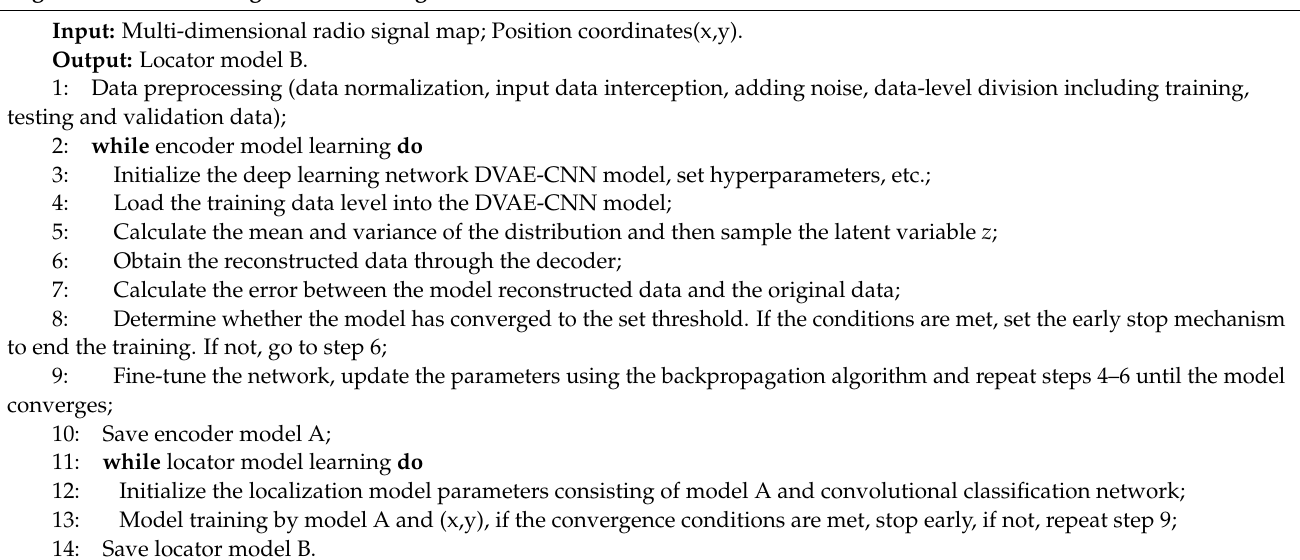
Figure 9. Locator model training process. The output of the encoder is converted into the input format of the CNN model through the Reshape method. At this time, the input feature is the high-level latent feature z related to the position, and the output is the position coordinate of the target. Pseudo code is shown in Algorithm 1. Algorithm 1: Positioning Model Training Process